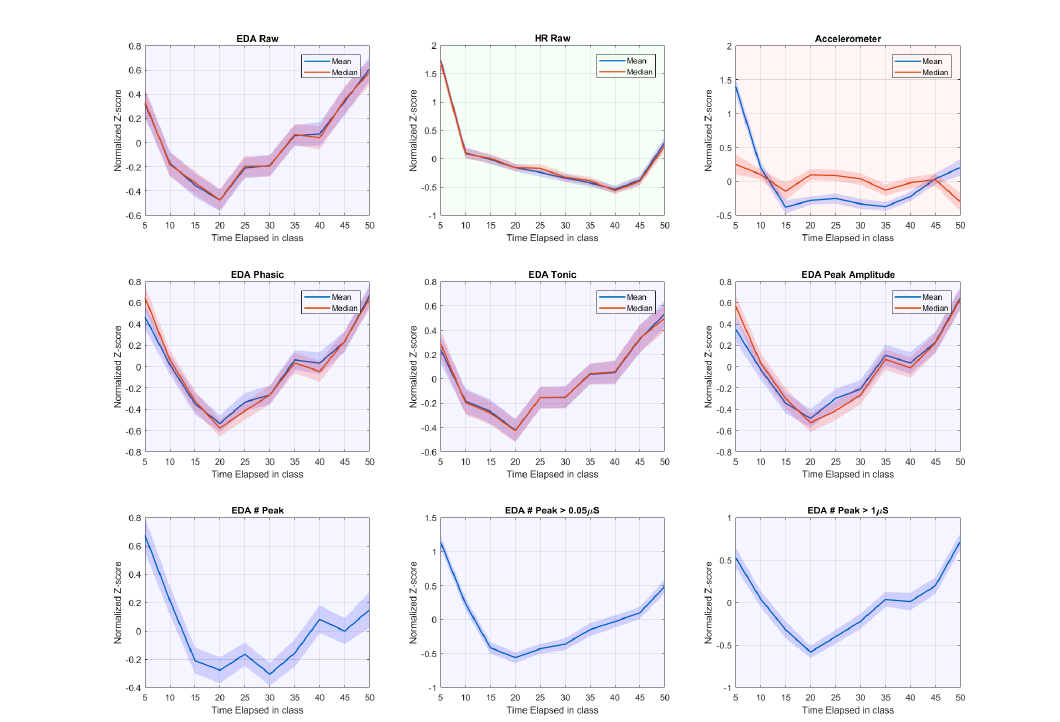
Figure 10. Normalized features of EDA, HR, and accelerometer data over the course of 50-min class. √ N where N = 85 participants for EDA and accelerometer and A shade area represents SD/ 80 participants for